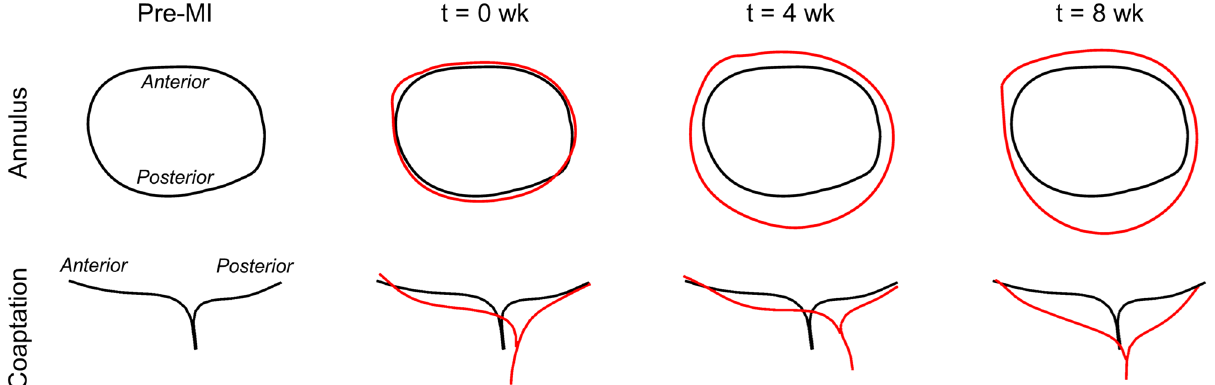
Figure 1. Post-MI changes in annulus shape and leaflet coaptation behaviour over time (pre-MI shown in black, post-MI shown in red). At t = 4 week and t = 8 week, both annular dilation and leaflet tethering are substantial but appear to have begun to